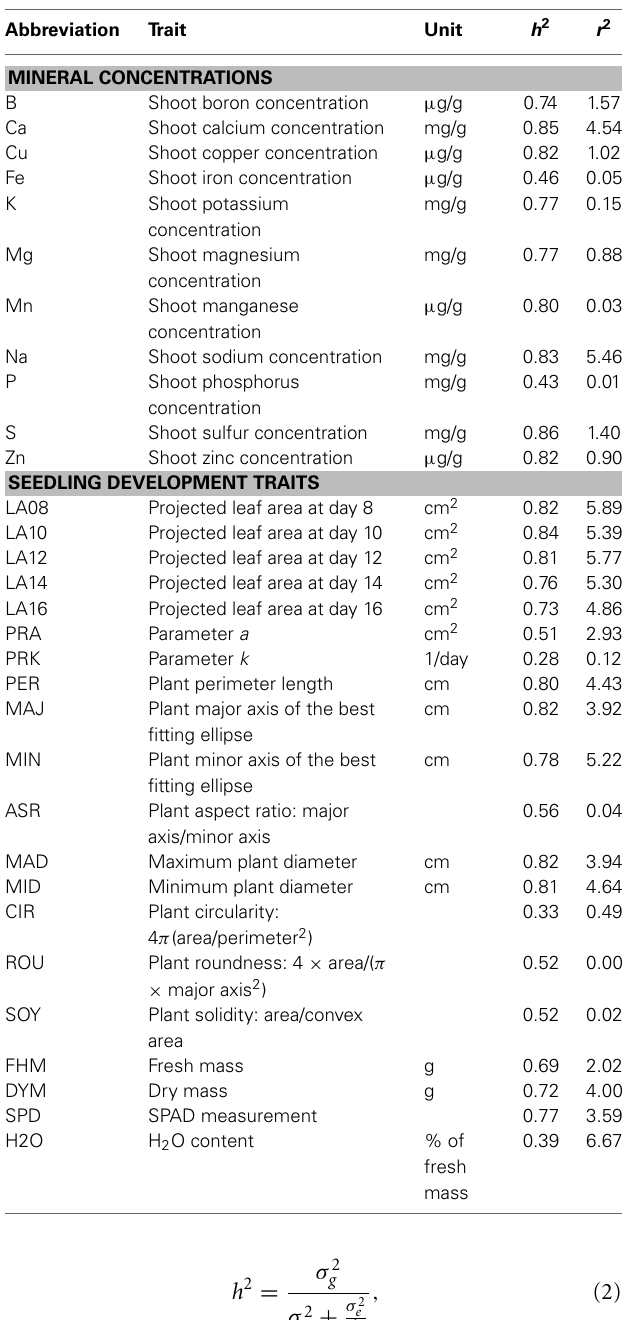
Table 1 | Abbreviations of eleven mineral concentrations and twenty seedling development traits, broad sense heritability on an entry mean basis ( h 2 ), and the percentage of phenotypic variation explained by population structure ( r 2 ) measured in a B. napus germplasm